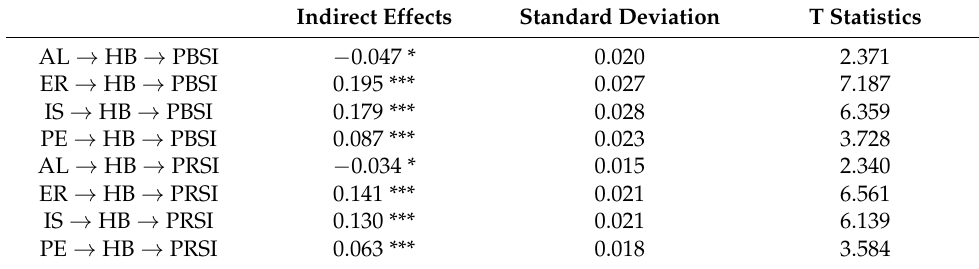
Table 9. Results for indirect